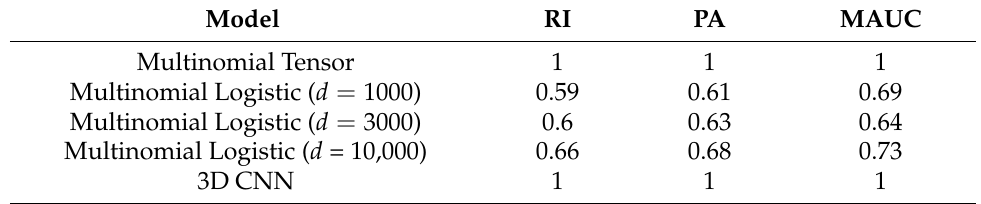
Table 2. The summary statistics for prediction performance on the training set for all methods.